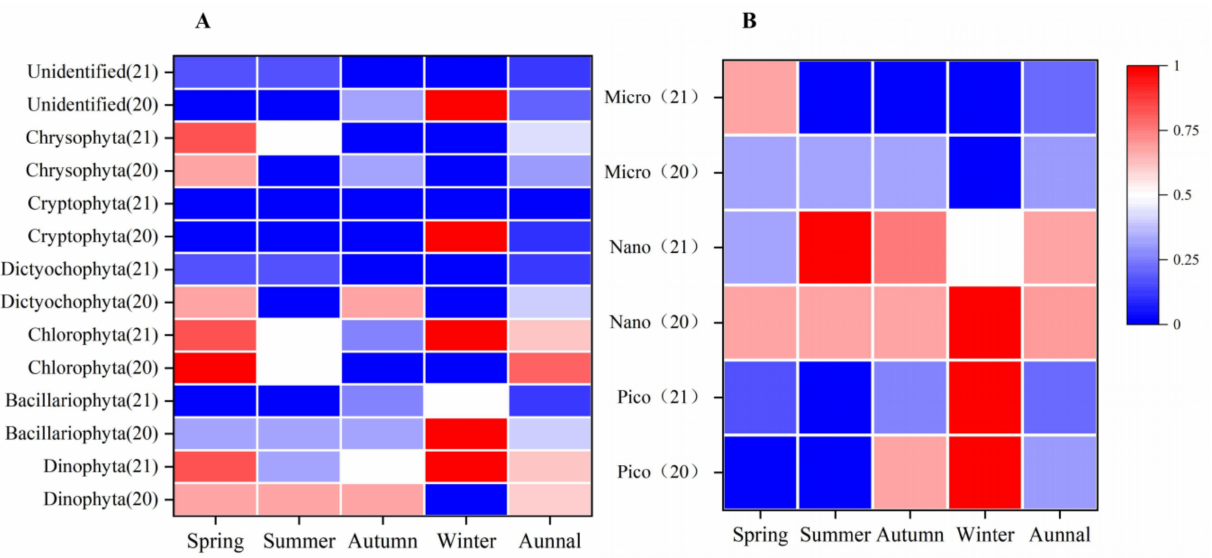
Figure 5. Selectivity index of R. philippinarum for phytoplankton in the Yalu River Estuary in 2020–2021: ( A ) various groups; ( B ) various sizes.